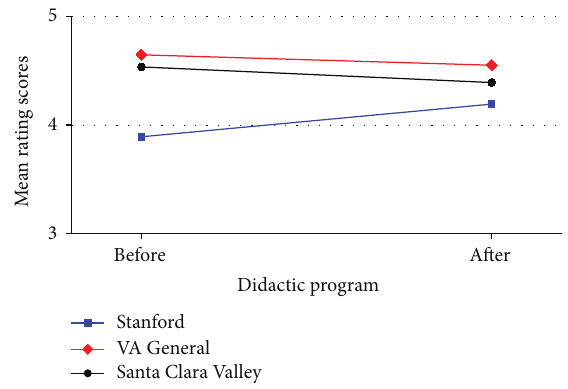
Figure 1: Hospital-level summary statistics for the primary end- point. Q8: overall teaching quality of this rotation, interaction